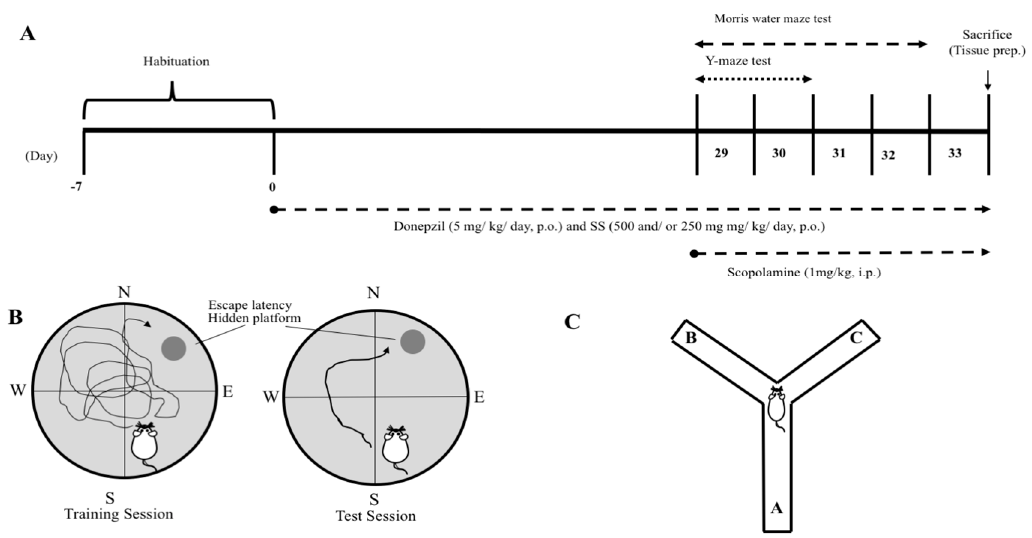
Figure 2. Animal experimental procedure. Schematic representation of the animal experimental protocol ( A ). Memory assessment paradigms used in this study Morris water maze ( B ) and Y-maze ( C ).